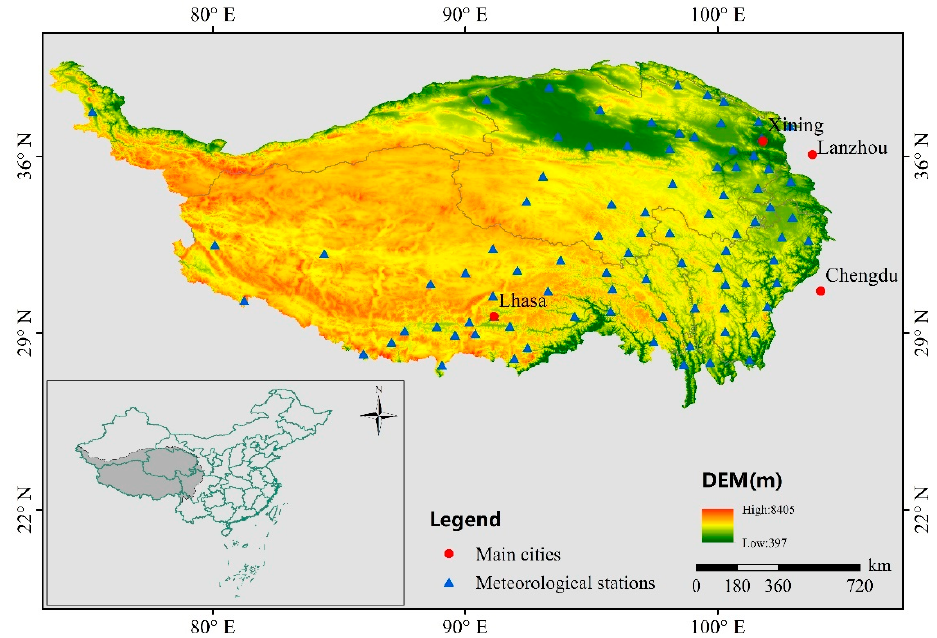
Figure 1. Overview of the TP and the locations of meteorological stations.